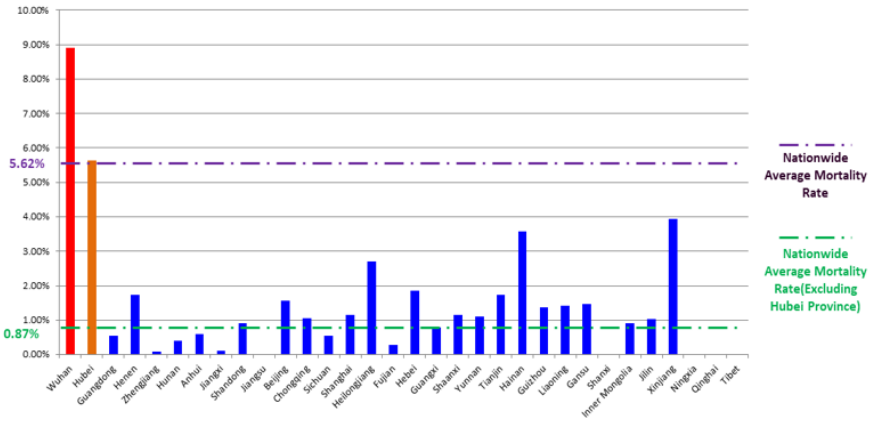
Figure 3. The mortality rate in Wuhan and all provinces and cities. Nationwide, as of 31 March, the mortality rate in Hubei Province, especially Wuhan, was higher than that in non-Hubei areas. The mortality rate in non-Hubei areas was only 0.087%, while the mortality rate was 5.64% in Hubei Province, 3.57% in the non-Wuhan area, and 8.91% in Wuhan. The national mortality rate was 5.62%.